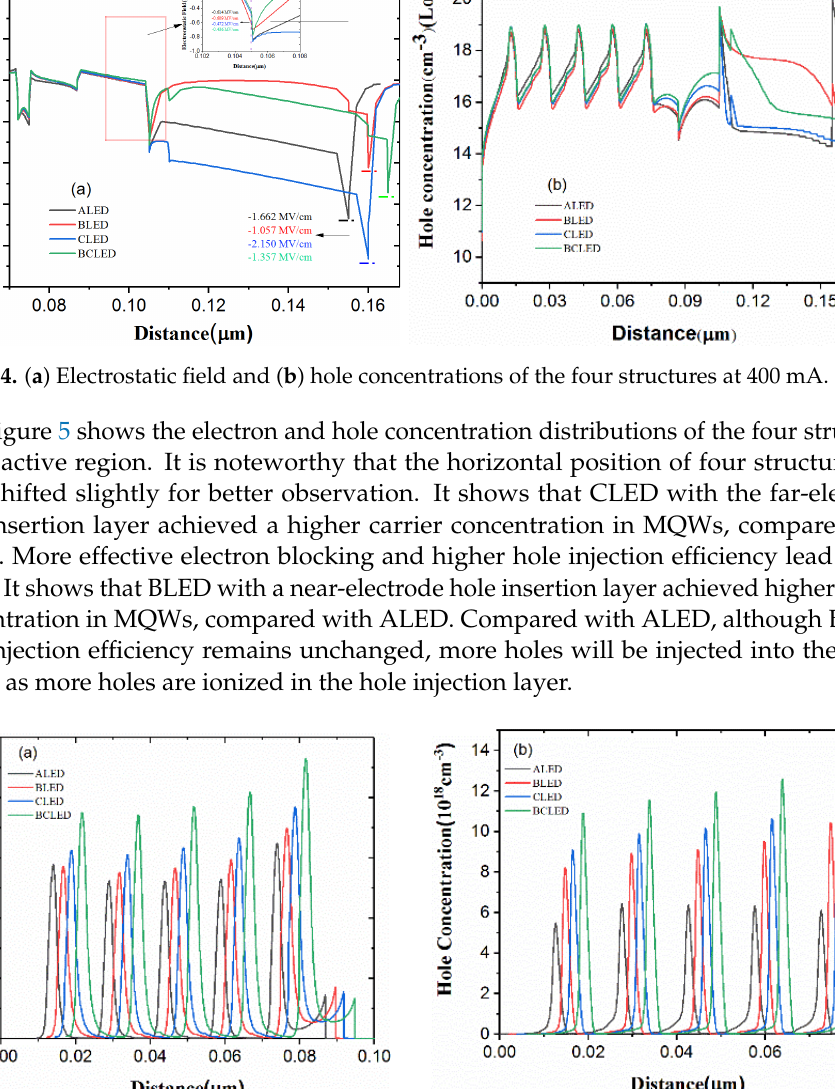
Figure 3. Energy band diagrams of ( a ) ALED, ( b ) BLED, ( c ) CLED, ( d ) BCLED at 400 mA respec- tively.